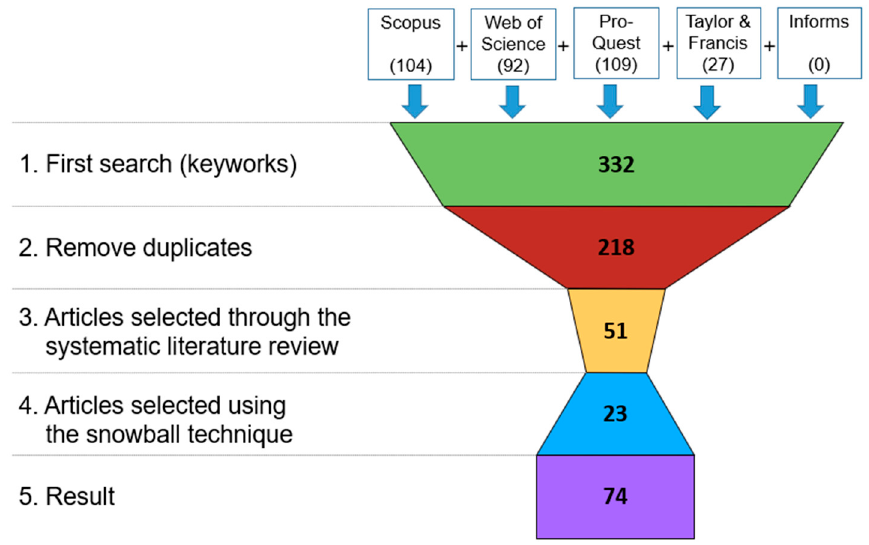
Figure 3. Search results summary.